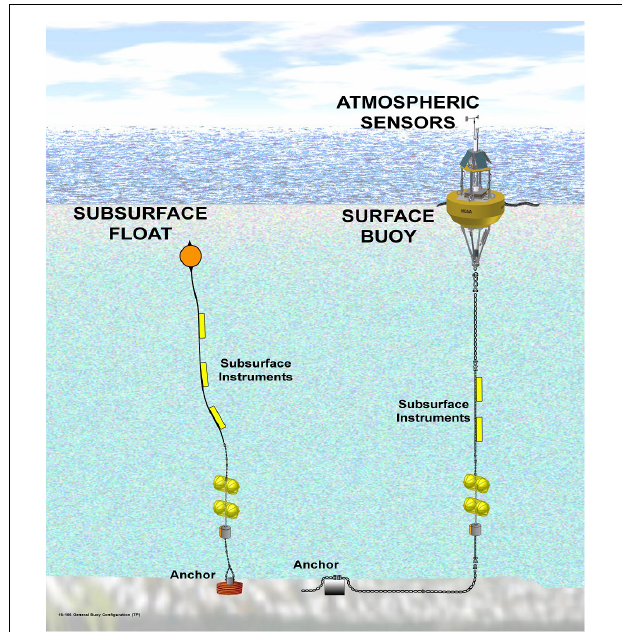
FIGURE 1 | Examples of coastal moorings. Coastal moorings may have a surface expression such as an instrumented data buoy or may be configured as an instrumented mooring in buoyant suspension below the surface of the ocean. Source: